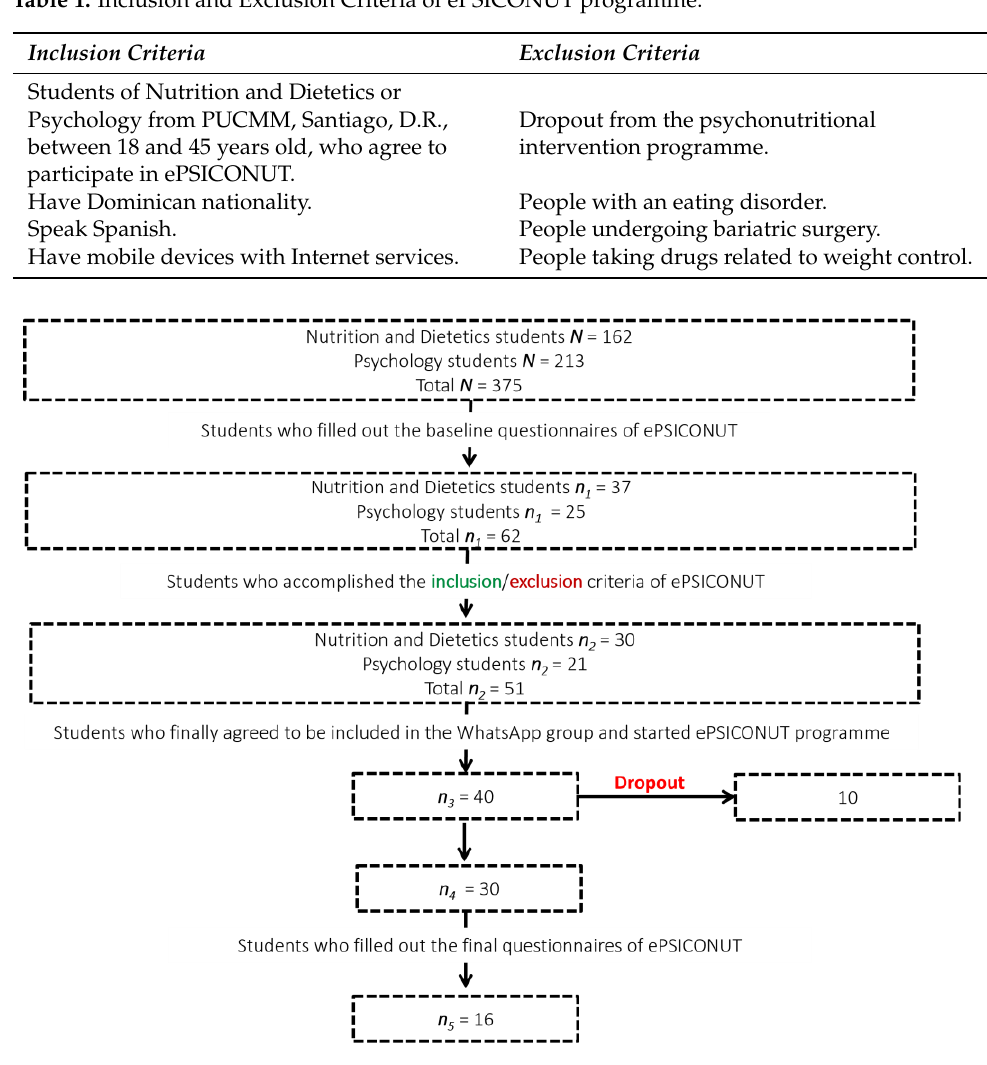
Figure 1. Evolution of the sample throughout the development of ePSICONUT programme.